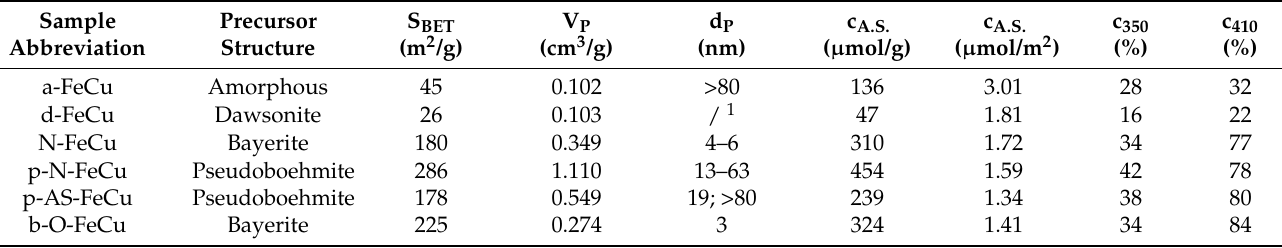
Table 2. Textural (S BET , V p , d P; see Supplementary Materials, Figure S2) and surface properties (c A.S.,; see Supplementary Materials, Figure S3) with catalytic activity as conversion at 350 and 410 ◦ C (c 350 and c 410 , based on catalytic activity presented in chapter Catalytic properties) of Cu-Fe containing